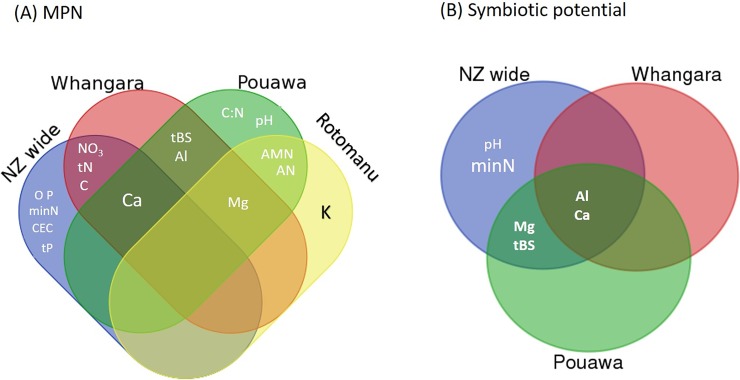
Venn diagrams showing similarity in properties of soils, at different spatial sampling scales, that have significant correlations with Rhizobium leguminosarum bv. trifolii population size (MPN’s; 6A), and symbiotic potential (6B).